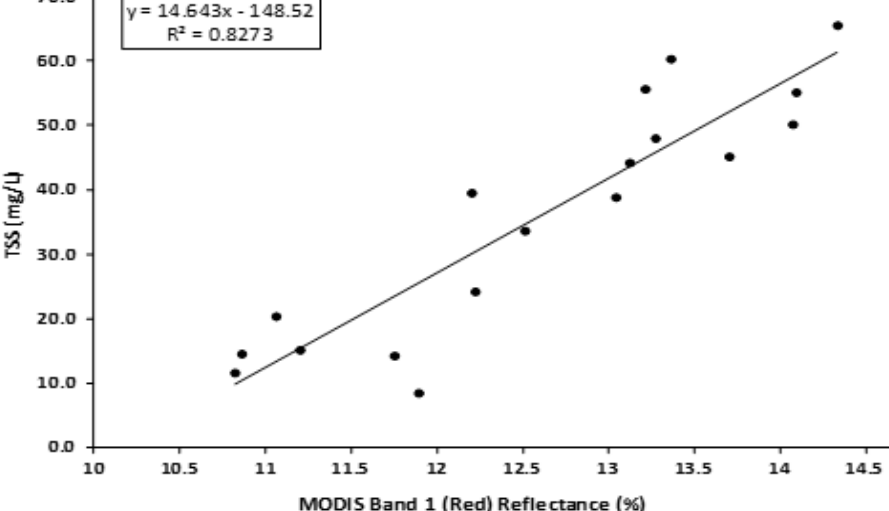
Figure 4. The correlation between MODIS Reflectance of Red Band (Band 1) and TSS.